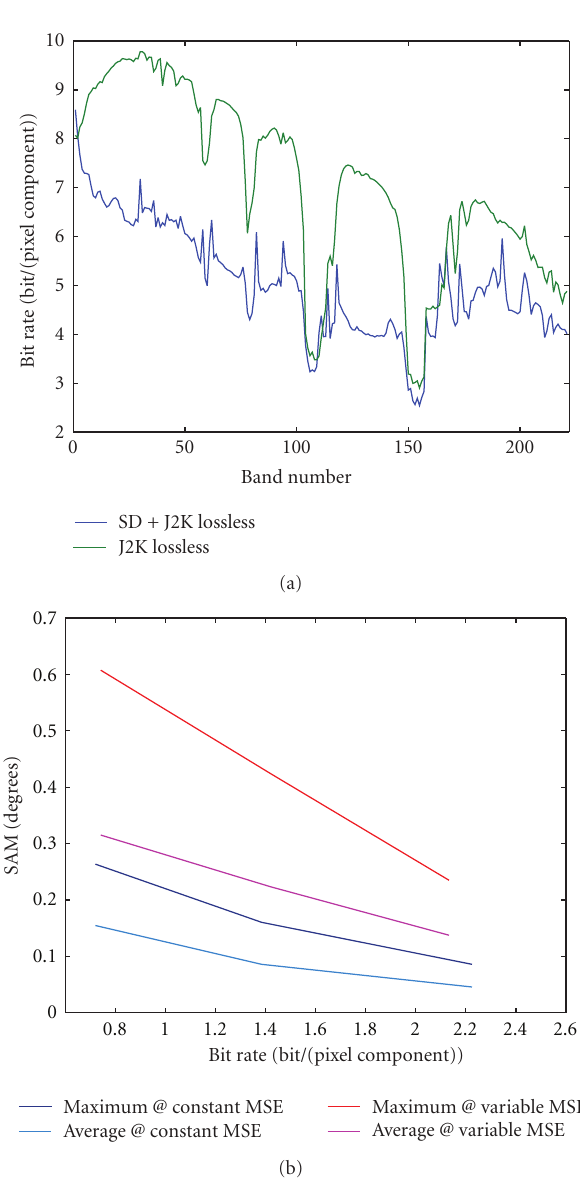
Figure 5: (a) Lossless compression of hyperspectral radiance data (AVIRIS’97) based on JPEG 2000, with and without spectral decorrelation; (b) SAM between original and compressed spectra varying with bit rate: MSE constant with wavelength versus MSE varying with